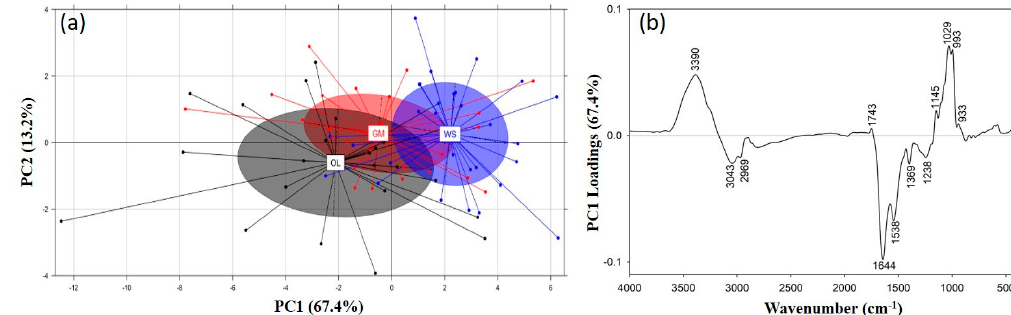
Figure 5. ( a ) Score plot of PCA (PC1 vs. PC2) for the discrimination of substrates (WS: wheat straw;